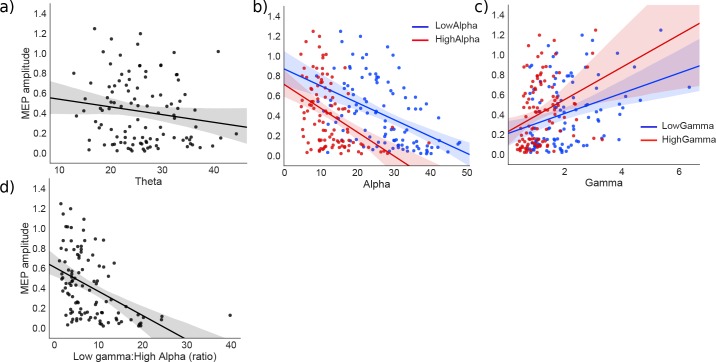
Regression plots of MEP amplitude with relative power for one representative subject.Panels (a-d) show scatterplots with lines of best fit for the regression performed on MEP amplitudes with relative power in each frequency band (only those with significant associations are displayed). The data points show all 120 trials (60 UP, 60 DOWN) collected during the combined TMS-EEG recording session, for a single representative participant.